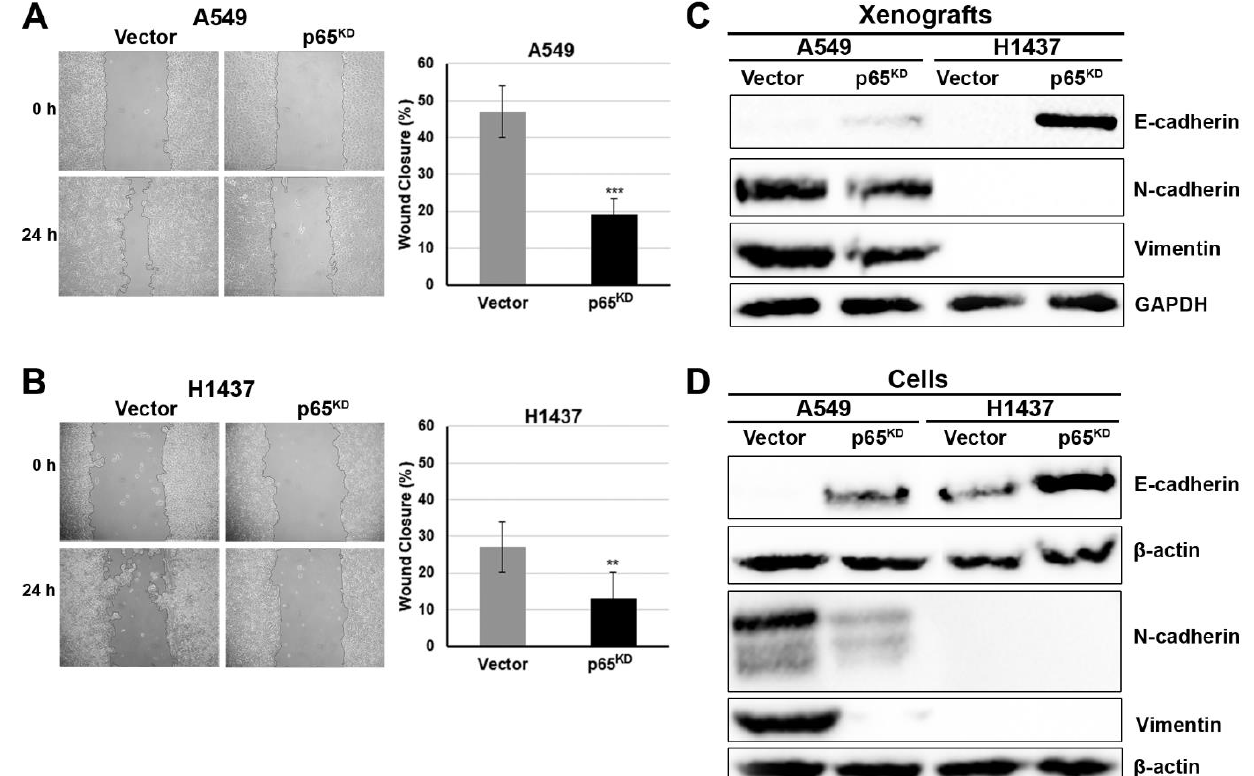
Figure 5. Loss of p65 reduces cell migration and enhances the expression of an epithelial cell phenotype. ( A , B ) In confluent monolayer cultures of vector control and p65 KD A549 and H1437 human lung cancer cells a scratch was generated, and the cells were allowed to heal the wound by establishing new cell-cell contacts. ( C , D ) Loss of RelA/p65 enhances the epithelial phenotype. Total protein lysates were extracted from vector control and p65 KD A549 and H1437 cancer cells either grown as tumours in in vivo xenografts in NSG mice ( C ) or cultured as monolayers in vitro ( D ), and analysed by immunoblotting for the expression of E-cadherin, N-cadherin and vimentin or GAPDH and β -actin as a reference control. The panels in Figure 5D resulted from the joining of strips of different blots. For all quantification analysis raw, unprocessed images were used. ** p < 0.01, *** p < 0.001.